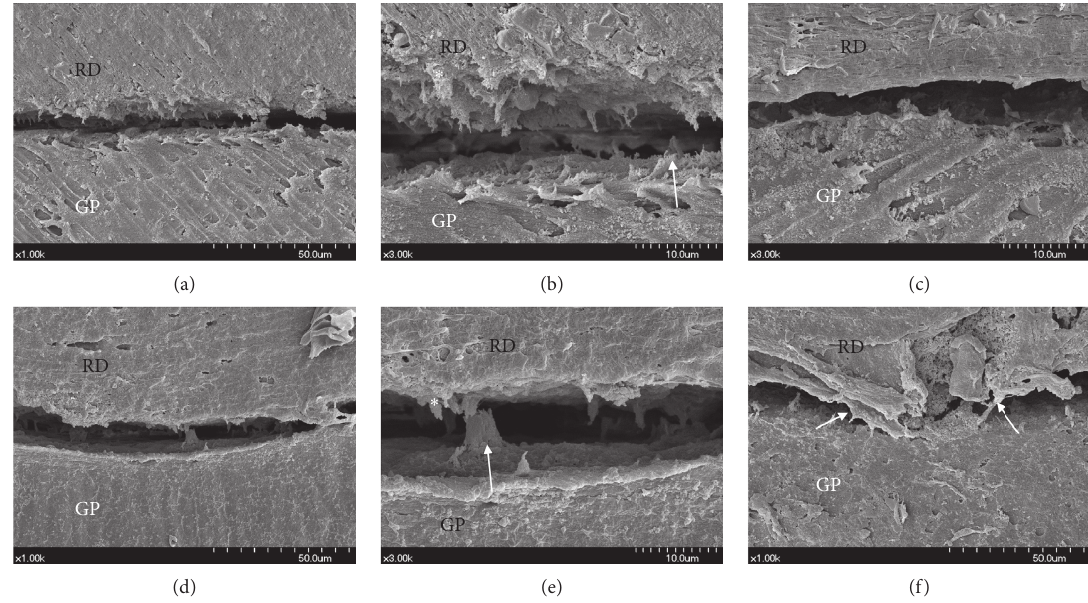
Figure 5: Representative scanning electron microscopy images of root canal-filled specimens. (a) Root canal filling with GP and AH Plus, (b) magnified view of (a) sealer is evident on the root dentin (asterisk) and GP (arrow), and (c) root canal filling with GP and AH Plus, and the root dentin is not coated with sealer. (d) Root canal filling with GP and GuttaFlow bioseal, (e) magnified view of (d) sealer is evident on the root dentin (asterisk) and GP (arrow), (f) root canal filling with GP and GuttaFlow bioseal, and GuttaFlow bioseal connecting the root dentin area and GP (arrows). RD, root dentin; GP, gutta-percha